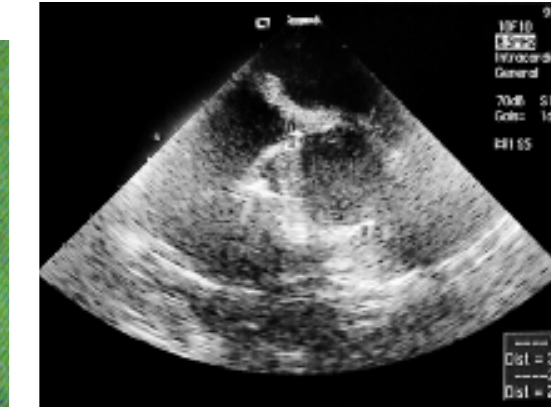
ICUS image. The probe is in the inferior vena cava – right atrium. Left ventricle free wall (bottom) and mitral valve (top) are identified to select the appropriate point to insert the catheter for the trans-apical aortic valve